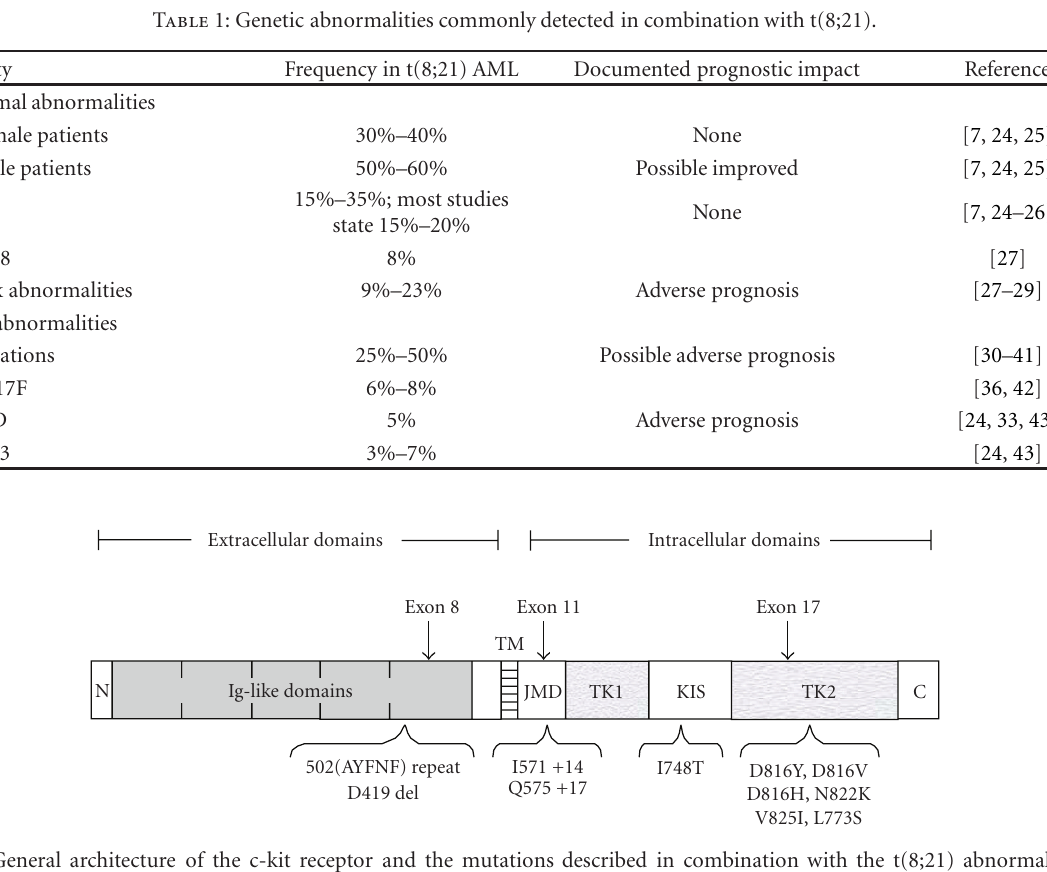
Figure 3: General architecture of the c-kit receptor and the mutations described in combination with the t(8;21) abnormality in the study by Wang et al. [30]. The c-kit type III receptor tyrosine kinase consists of an extracellular ligand-binding portion comprising five immunoglobulin-(Ig-) like repeats, a single transmembrane (TM) domain, a juxtamembrane domain (JMD), and a cytoplasmic portion containing and a split tyrosine kinase domain (TK1 and TK2) with a kinase insert sequence (KIS). Locations of c-kit abnormalities found in t(8;21) AML are indicated by the arrows. c-kit mutations are found more frequently within the extracellular fifth immunoglobulin-like domain (exon 8) and the second tyrosine kinase domain which contains the activation loop (exon